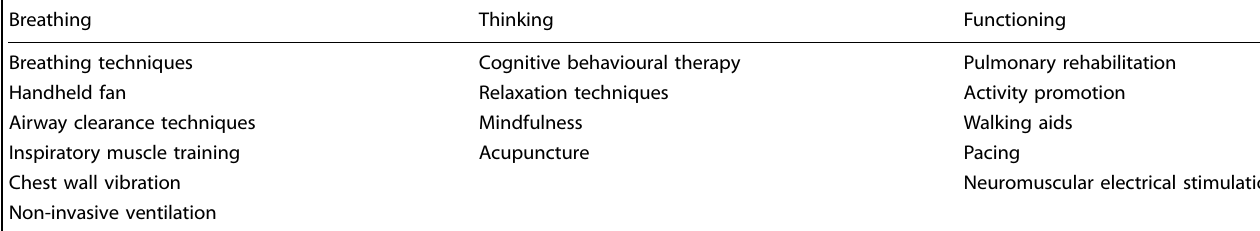
Table 2. Categorisation of symptom management approaches according to Breathing, Thinking, Functioning domain